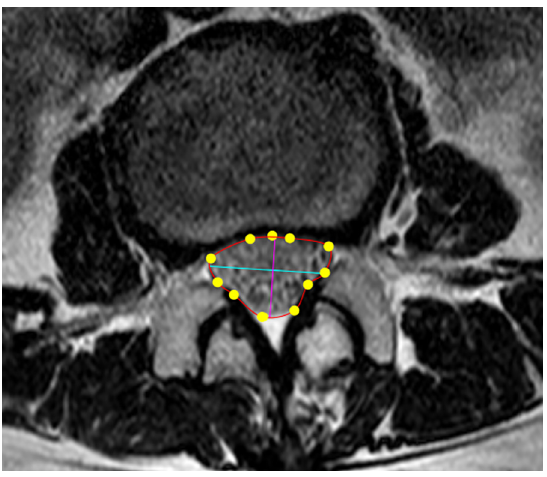
Fig 2. Illustration of the dural sac cross-sectional area measurement technique.